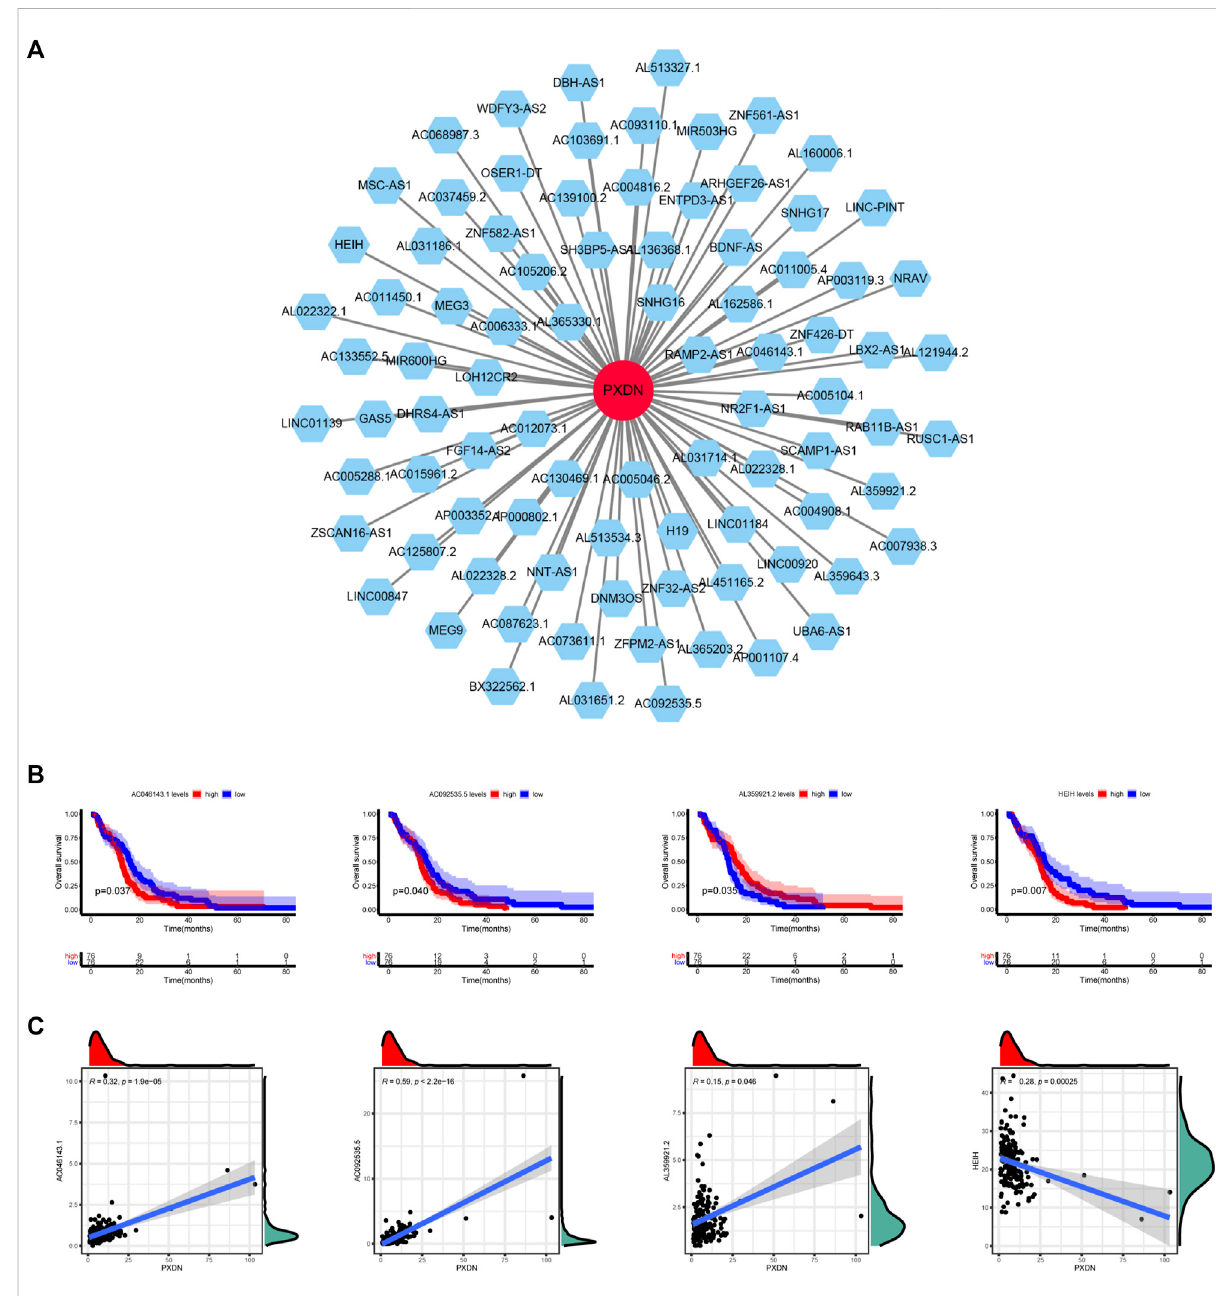
FIGURE 8 Determination of PXDN-related lncRNAs. (A) PXND-lncRNAs correlation regulation network. (B) Survival analysis of four lncRNAs. (C) Correlation analysis of four